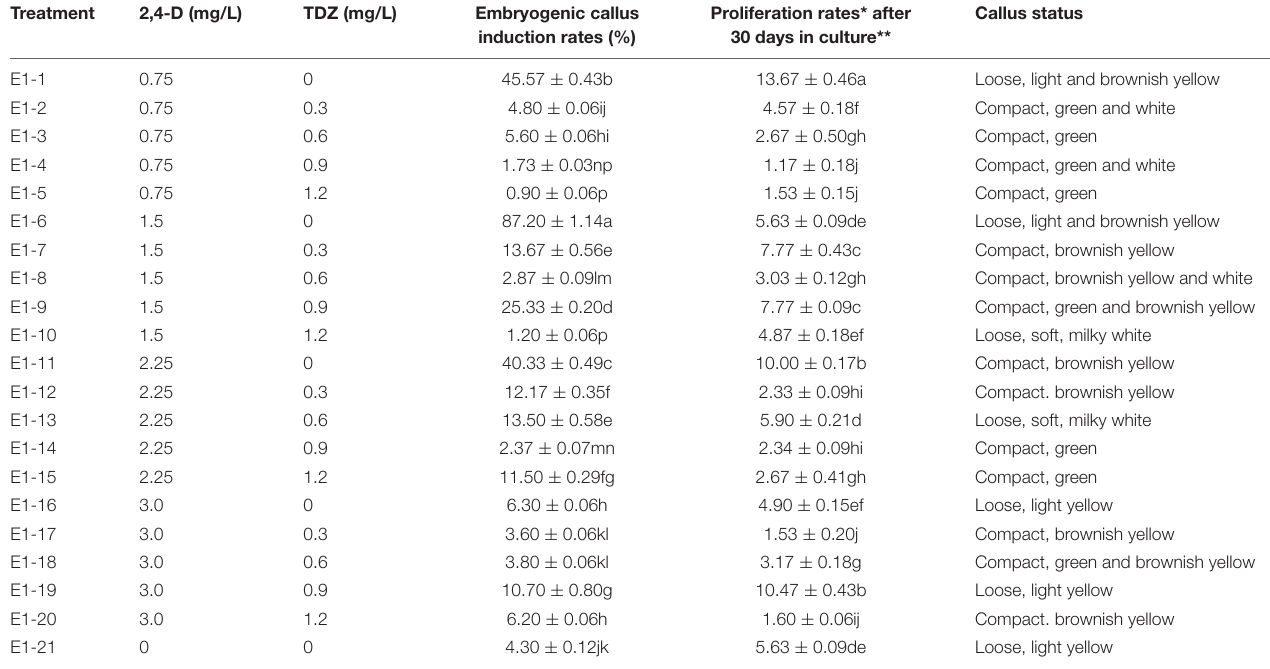
TABLE 2 | The induction and proliferation rates of C. oleifera embryogenic callus with the combination of different concentrations of 2,4-D and TDZ. Treatment 2,4-D (mg/L)